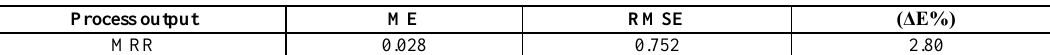
Table 6. Accuracy of predictive model